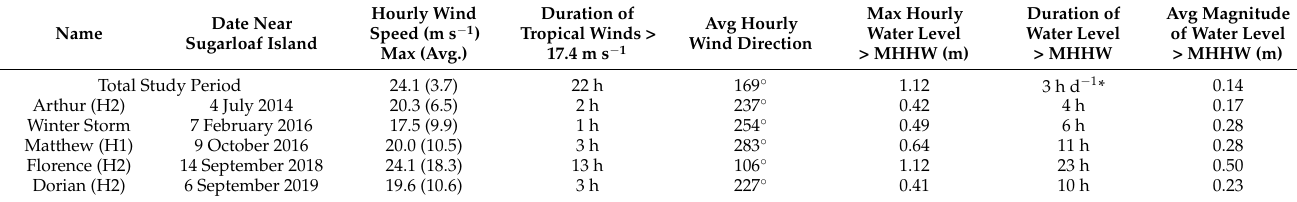
Table 3. Summary of wind and water level characteristics of storm events that impacted Sugarloaf Island, NC, between 2014 and 2020. Note that maximum hourly wind speed is reported outside of parentheses, and average hourly wind speed is reported inside parentheses. Wind and water level duration are reported in hours (h). Duration of water level > MHHW for the total study period is reported in hours per day (h d − 1 ) and is highlighted by the